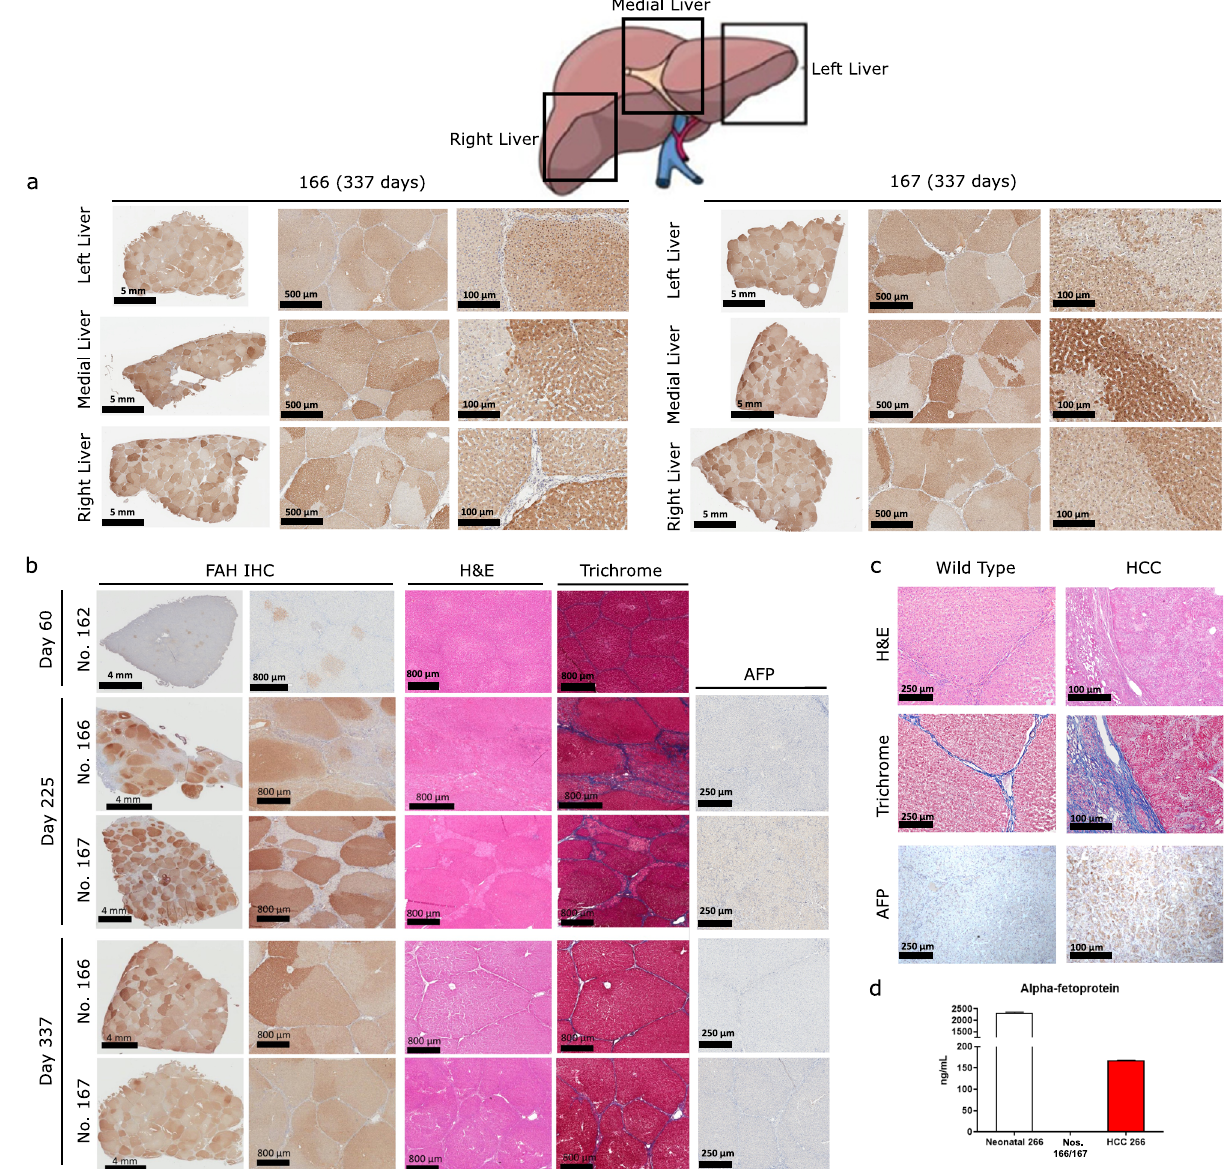
Fig. 3 | Liver repopulation with FAH-positive hepatocytes after in vivo LV-FAH delivery.a Immunohistochemistry(IHC)forFAHinNos.166and167 atthetimeof euthanasia(337dayspost-treatment)showingliverrepopulationwithFAH-positive hepatocytesinall areasof the liver.Sixteen areasofeach liverwereexaminedwith similar results for a – c . b IHCforFAH in No. 162 at60days post-treatment showing multipleFAH-positivenodulesintheliverwithnopresenceofsigni fi cantliverinjury on H&E or Trichrome staining ( fi rst row). IHC for FAH from laparoscopic liver biopsy in No. 166 (second row) and No. 167 (third row) at 225days post-treatment showingextensiveliverrepopulationwithFAH-positivehepatocytes,withH&Eand Trichrome staining showing hepatocellular in fl ammation with moderate fi brosis butnoincreasedAFPstaining.IHCforFAHinNo.166(leftmediallobe,fourthrow)